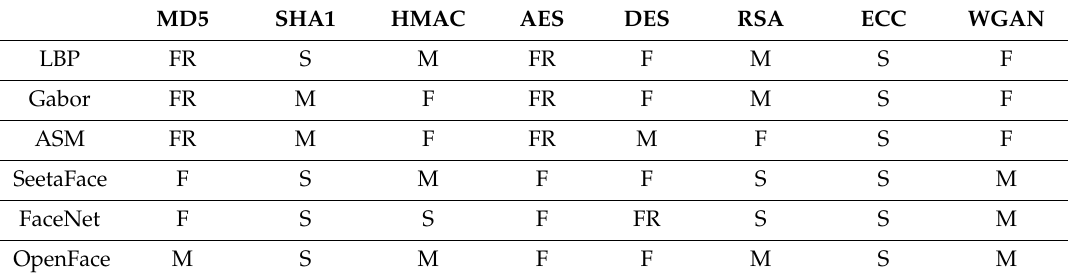
Table 4. E ffi ciency analysis (S, Slow [ > 1]; M, Medium [0.1–0.9]; F, Fast [0.01–0.09]; FR, Faster [ <